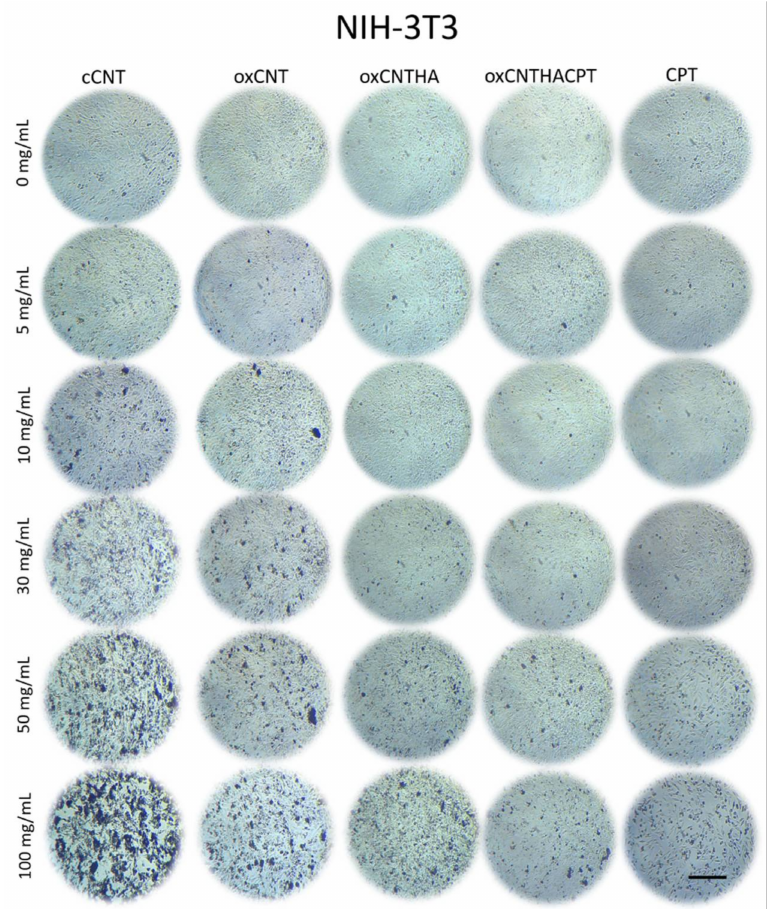
Figure 2. Micrographs of NIH-3T3 exposed for 24 h to 0, 5, 10, 30, 50 and 100 µ g/mL. Note that the higher the concentration of the commercial-grade carbon nanotubes (cCNT), the greater the agglomeration of the nanoparticles, and the lower of cell confluence. In the oxidized CNTs (oxCNTs), oxidized and functionalized CNTs (oxCNT–HA), and the oxidized and functionalized CNTs loaded with CPT (oxCNTs–HA-CPT) treatments, the higher the concentration of the treatment the fewer agglomerates, and the cell confluence does not decrease significantly. Interestingly, in the Carboplatin (CPT) treatments, note that the higher the concentration, the lower the cell confluence. The cells detach from the well due to the cytotoxicity of the treatment and change their morphology. Scale = 200 µ m.